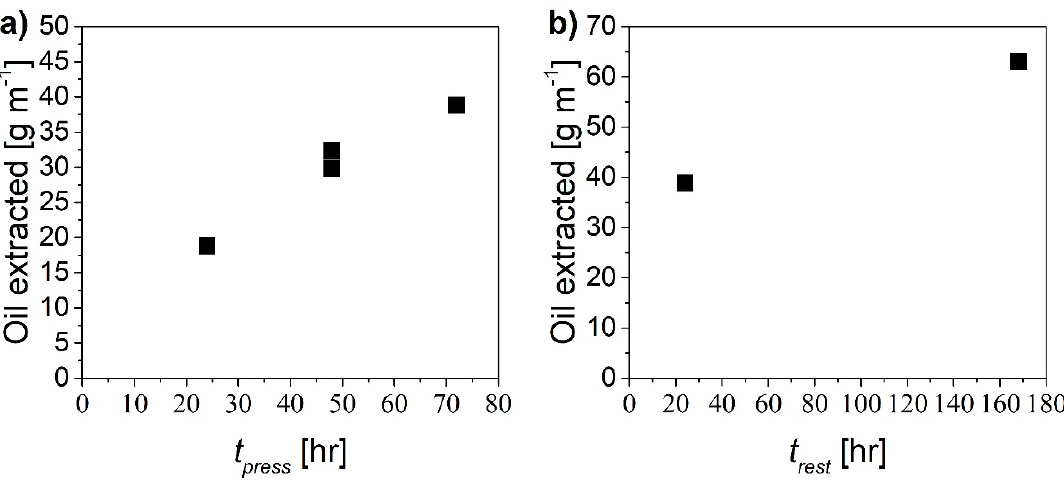
Figure 7. Amount of oil extracted as a function of ( a ) pressurization time at constant t rest equal to 24 h and ( b ) rest time at constant t press equal to 72 h.